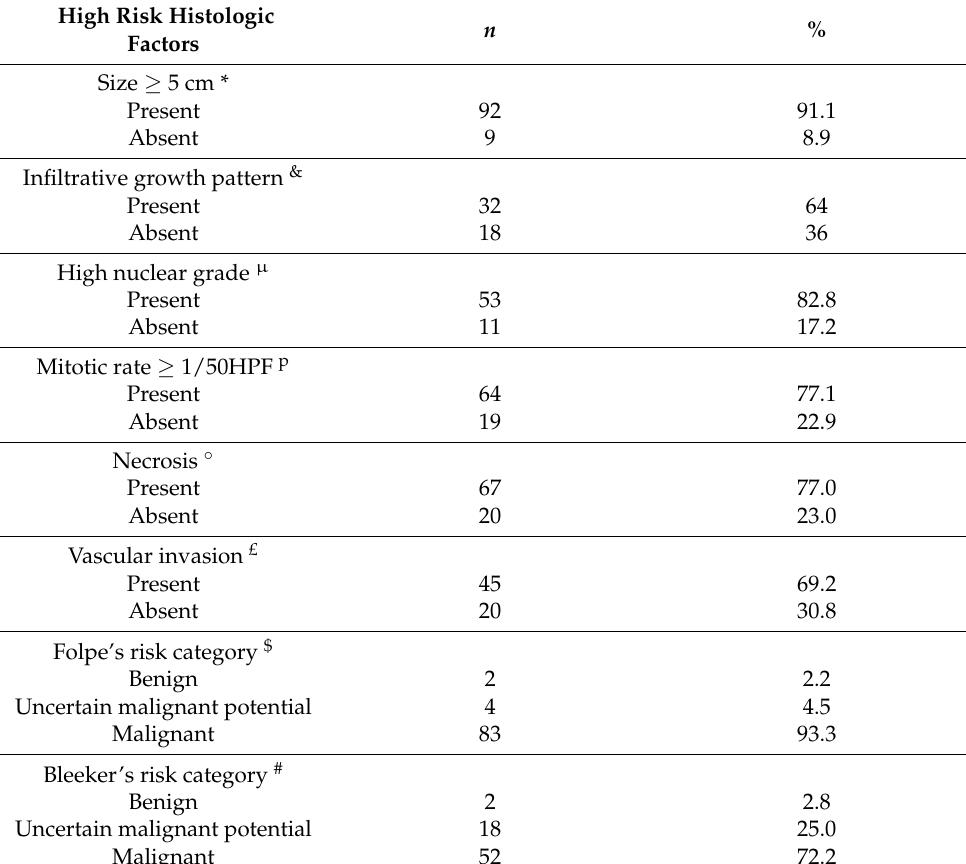
Table 3. Details on high-risk features described as Folpe’s criteria and Folpe and Bleeker’s risk classification from individual case reports ( N =